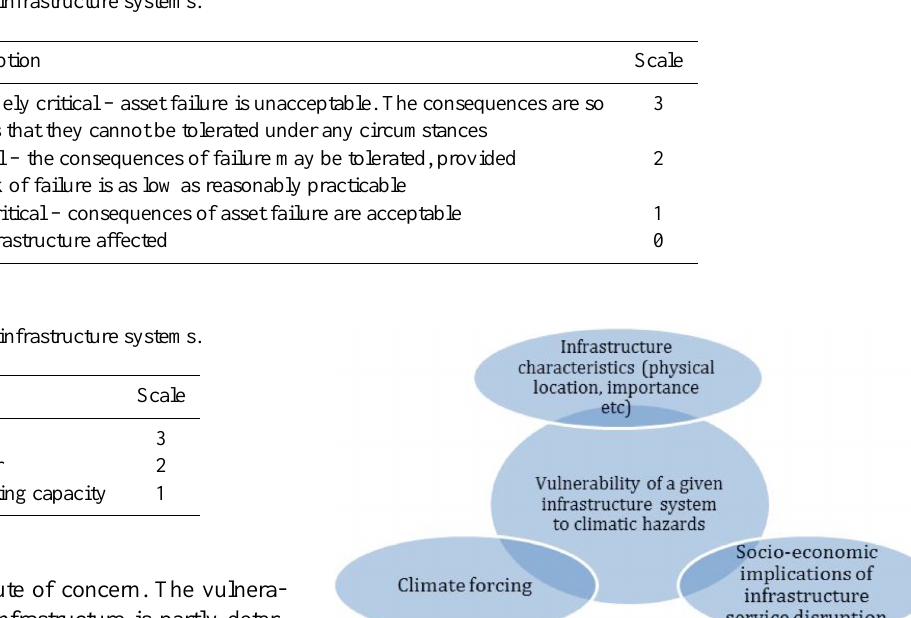
Table 2. Scales used for V2 for all infrastructure systems.